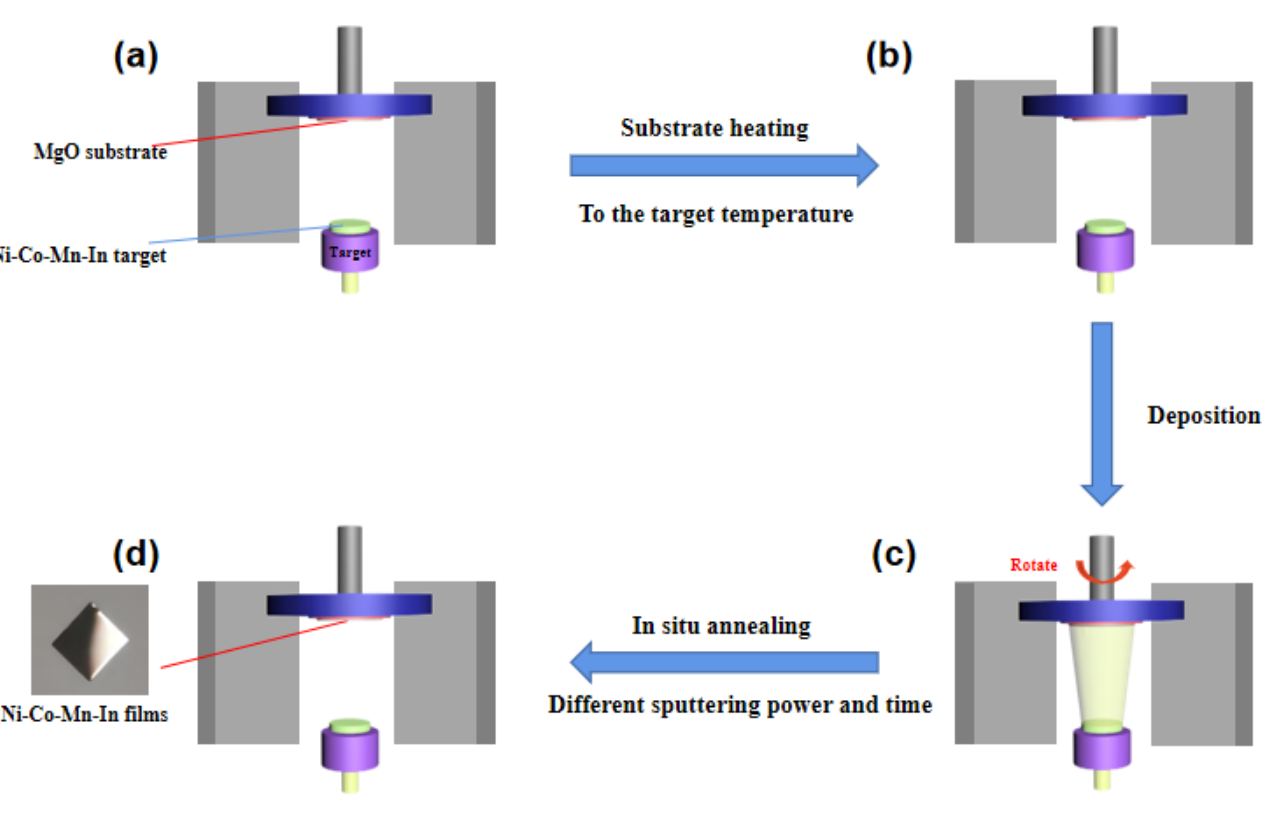
Figure 2. Schematic fabrication of the Ni-Co-Mn-In alloy thin film. ( a ) Put in the substrate; ( b ) Heater the sample table; ( c ) Deposition; ( d ) Annealing. Table 1. The obtention parameters of each sample for the Ni-Co-Mn-In alloy films. Samples